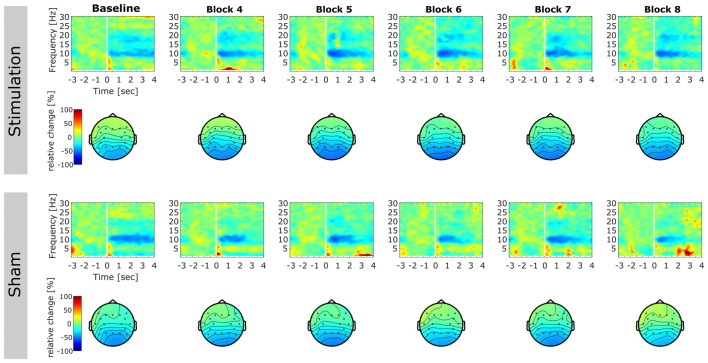
Event-related relative power change. Time-frequency representations (TFRs) and topographies reflecting relative change in spectral power after onset of the mental rotation stimulus with respect to baseline (3000 ms prior to stimulus onset until stimulus onset). TFRs are averaged over subjects for each block on electrode Pz. Topographies illustrate relative change in alpha power (8–12 Hz) in the time window 0–3000 ms after stimulus onset. First column displays pre-stimulation baseline. Later columns illustrate post stimulation blocks. Please note that blocks 2 and 3 were performed during stimulation and were discarded from analysis. Top rows: TFRs and topographies of the stimulation group. Bottom rows: TFRs and topographies of the sham group.